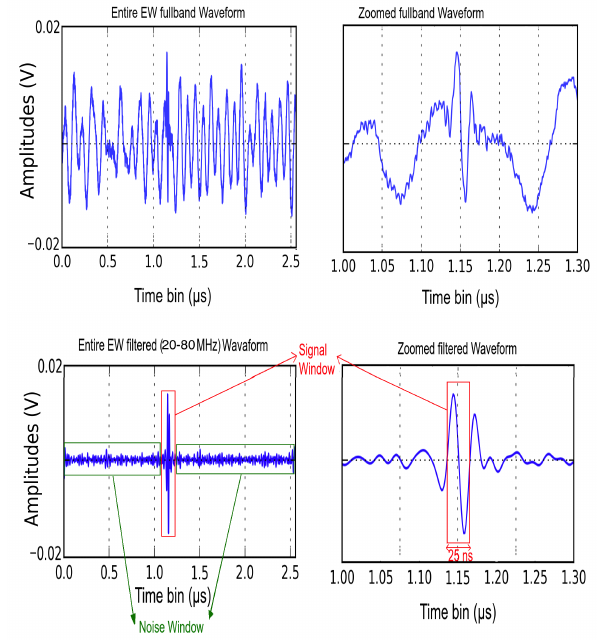
Figure 3. The upper plots show the raw EW waveform of a cos- mic event. The lower plots show the corresponding filtered signal in the 20-80MHz band. In both cases the full waveform (left) and the central region (right) are presented.